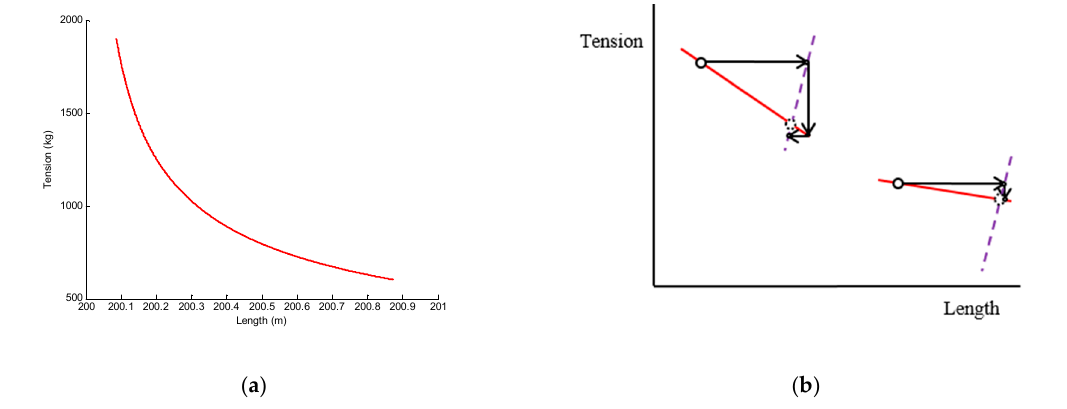
Figure 3. ( a ) Length–tension curve for a catenary ( a = 200 m, ACSR Hawk). ( b ) Tension change due to the same conductor temperature change.